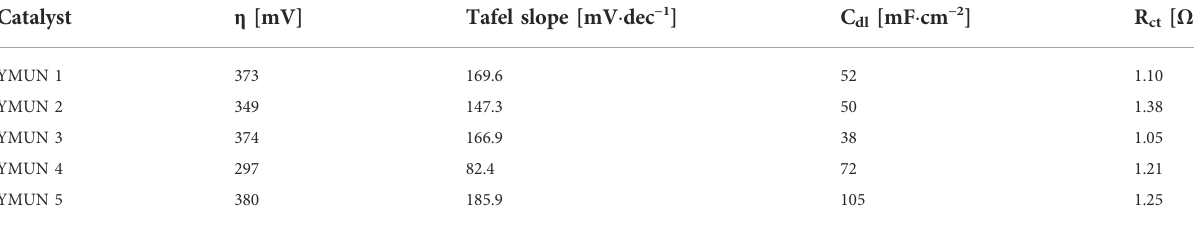
TABLE 2 Summarized OER catalytic parameters of different catalysts in a 1.0 M KOH electrolyte.